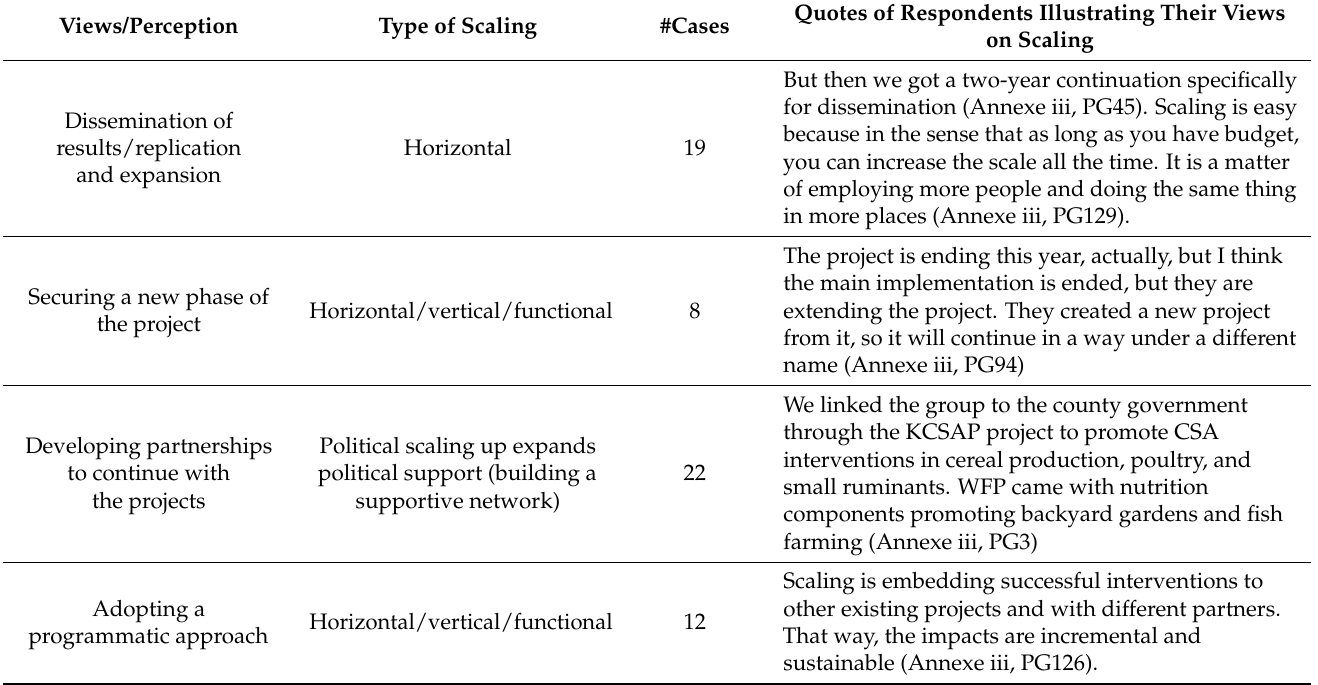
Table 3. Perceptions and views on